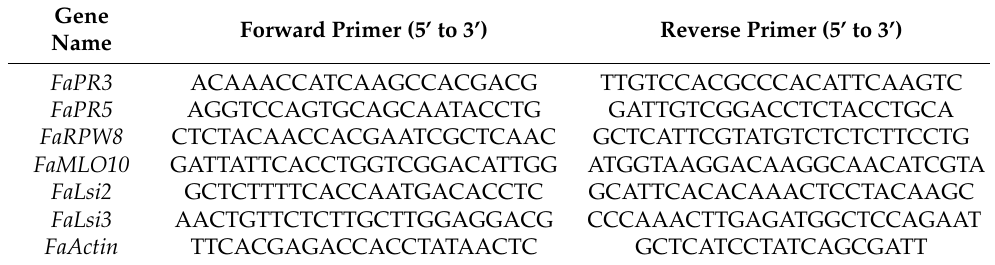
Table 3. List of qPCR primers used in this